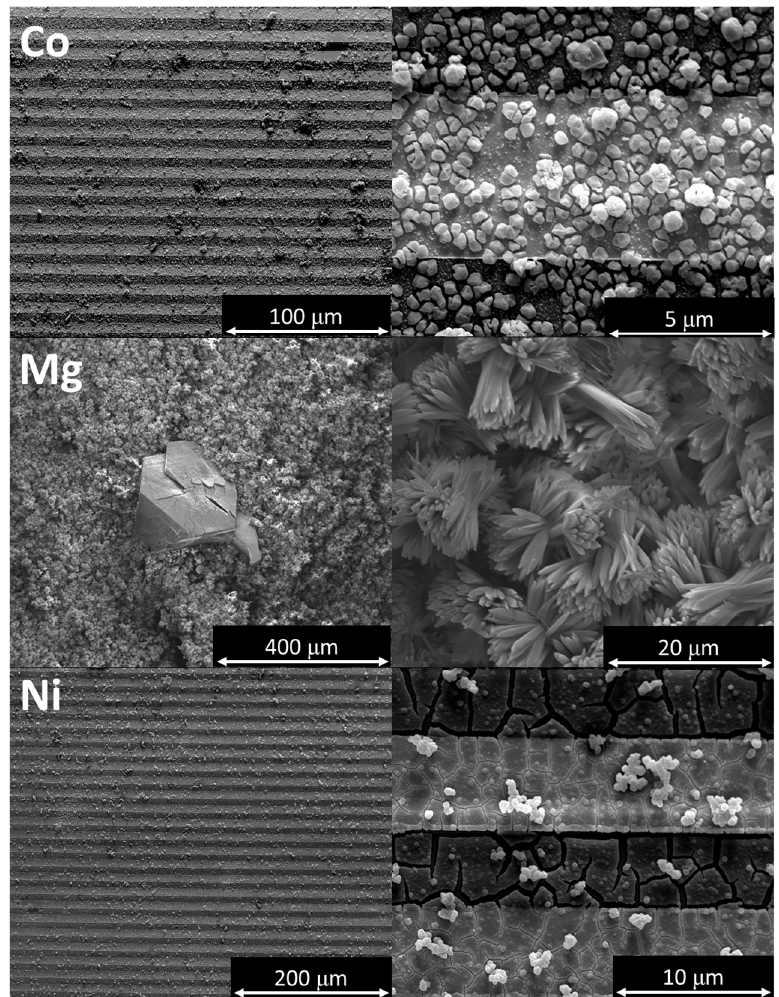
Figure 5. Scanning electron micrographs of Co-MOF-74 (top), Mg-MOF-74 (middle) and Ni-MOF-74 (bottom) thin film membranes grown on silica/Pt functionalized IDEs. The Ni-MOF-74 membrane is continuous across Pt wires, with evidence of cracking only seen on the silica support.